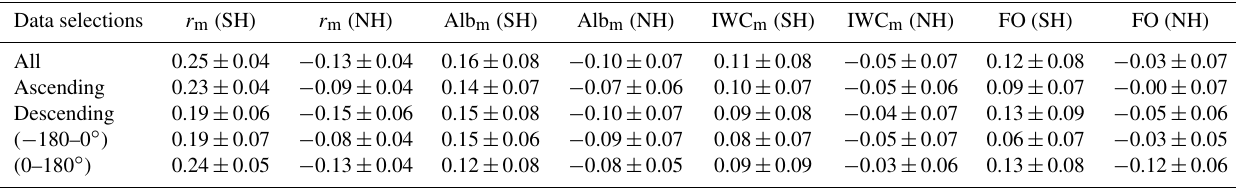
Figure 3. Correlation coefficients between the anomaly of r m , Alb m , IWC m and IMF B y from 2007 to 2017, with red and blue symbols representing the seasonal correlation coefficients and dashed red and blue lines illustrating the mean correlation coefficients for the SH and NH, respectively. Table 2. The correlation coefficients of NLC properties with IMF B y under different selections of satellite branches and longitudinal ranges for CIPS